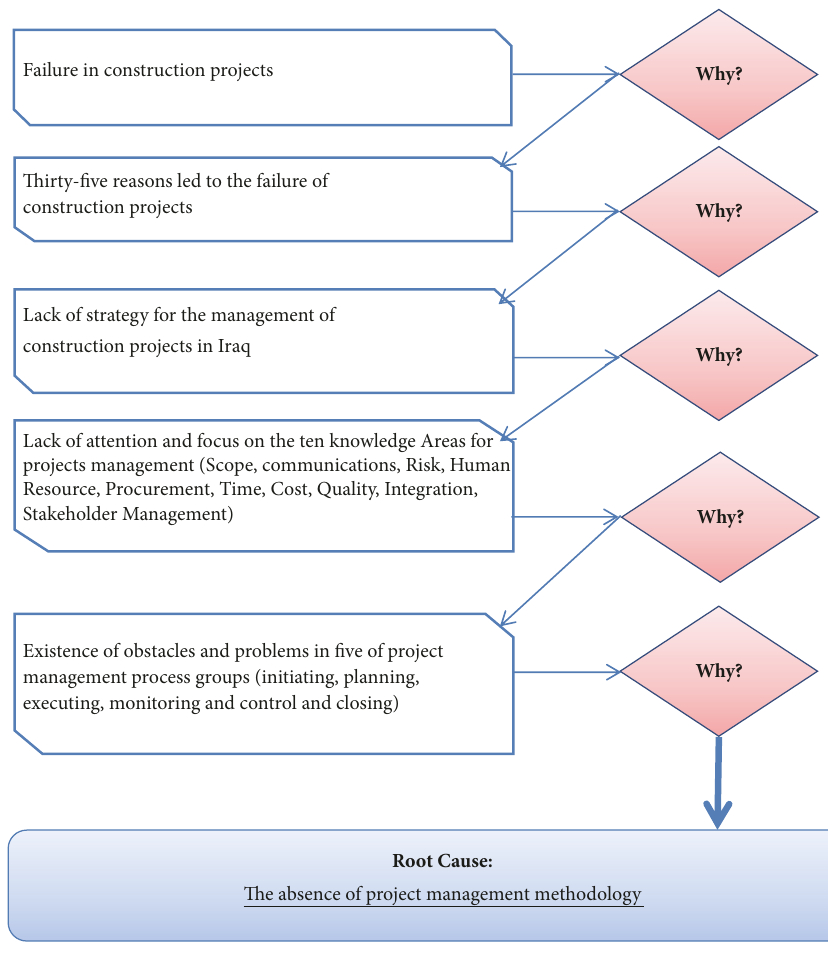
Figure 15: Five-why